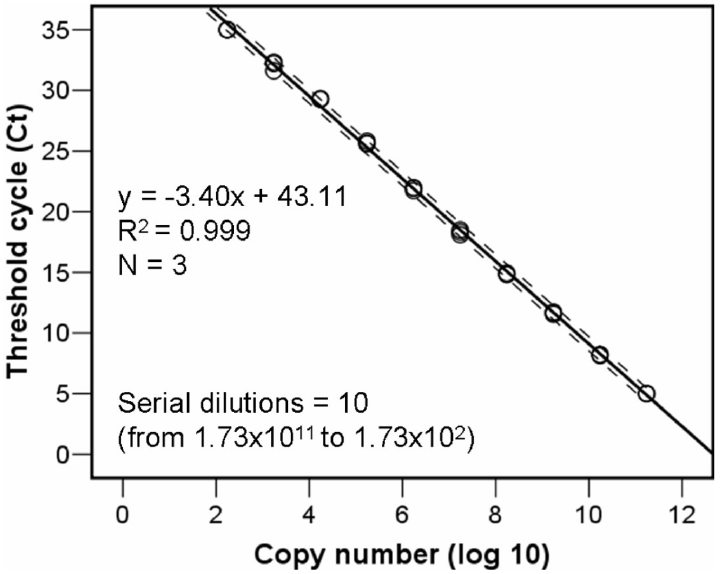
Figure 1. Regression equation relating the CHV ‐ 1 virus copy number with threshold cycle values.